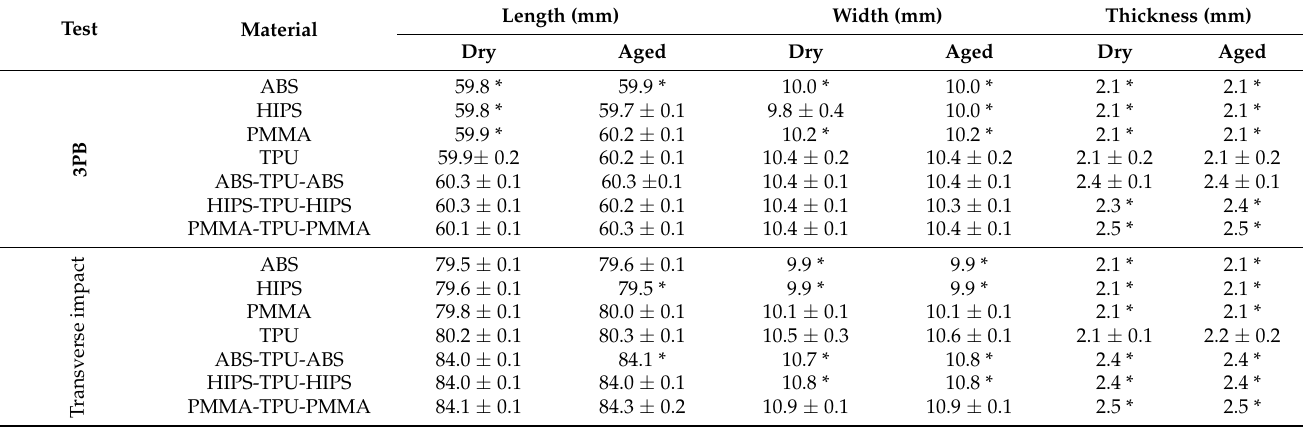
Table 2. Mean average and standard deviation values of the dimensions of the printed before (dry) and after (aged) the aging